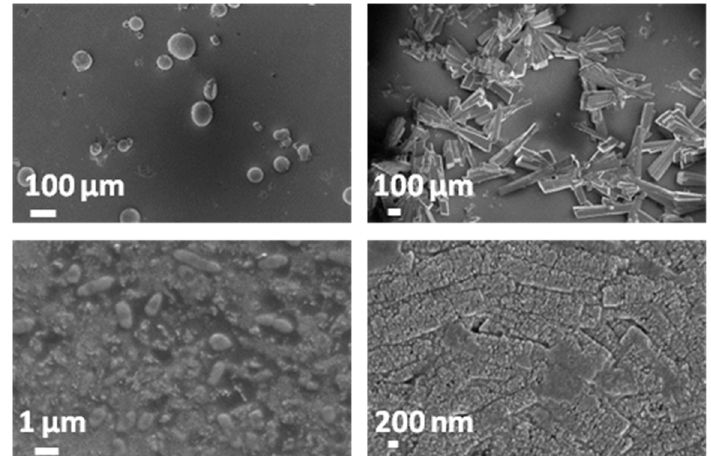
Figure 17. Chemical composition of three different precipitates formed at the surface of PLA support after immersion in artificial urine for 21 days.